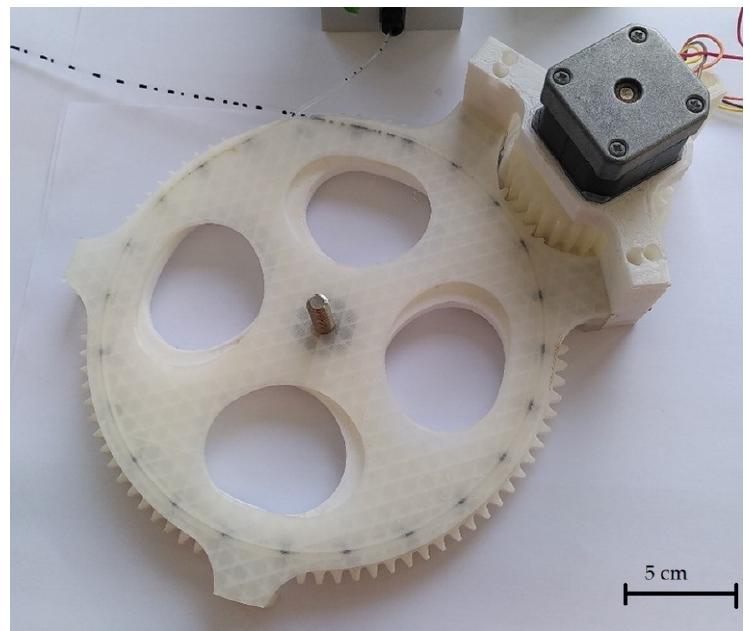
Figure 4. Design of the magnetic gear pump with recessed capillary and an uneven two-phase flow.